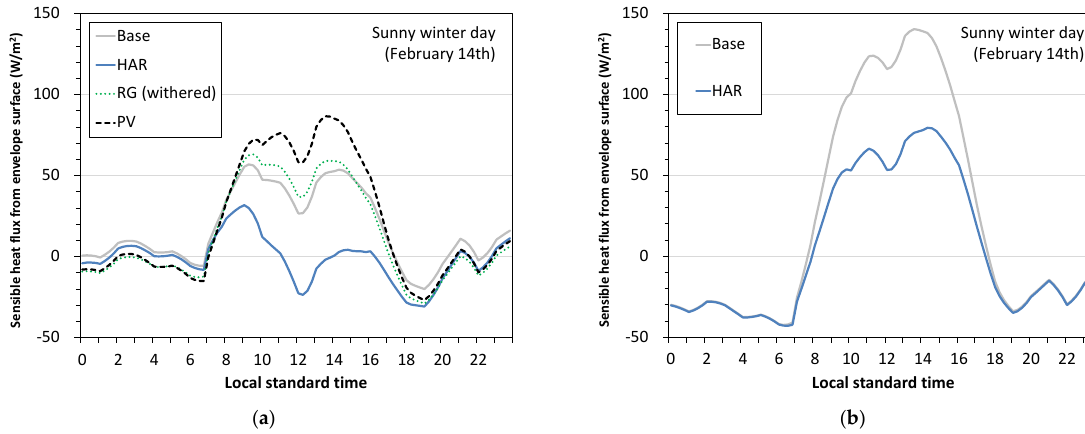
Figure 7. Time series of the sensible heat release from an envelope surface on a representative sunny winter day for ( a ) reinforced concrete structure and ( b ) wooden structure with low insulation level.